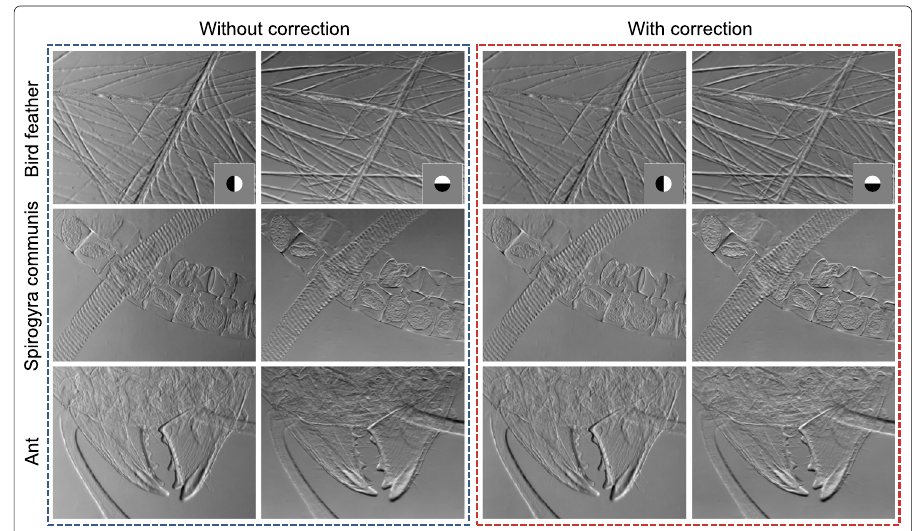
Fig. 22 Comparison of phase gradient results of bird feather, spirogyra communis, and ant under DPC imaging without and with removing tilt error